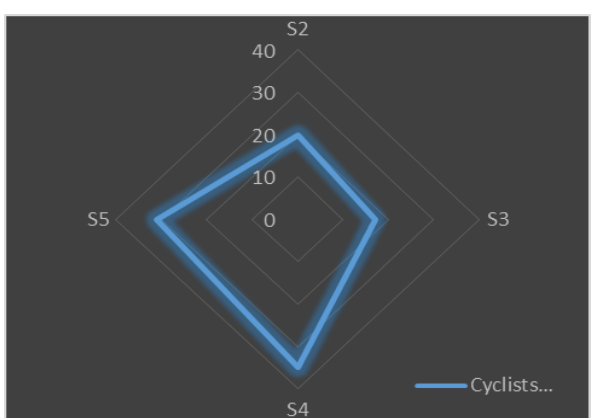
Figure 2: Cycling trips per time of day